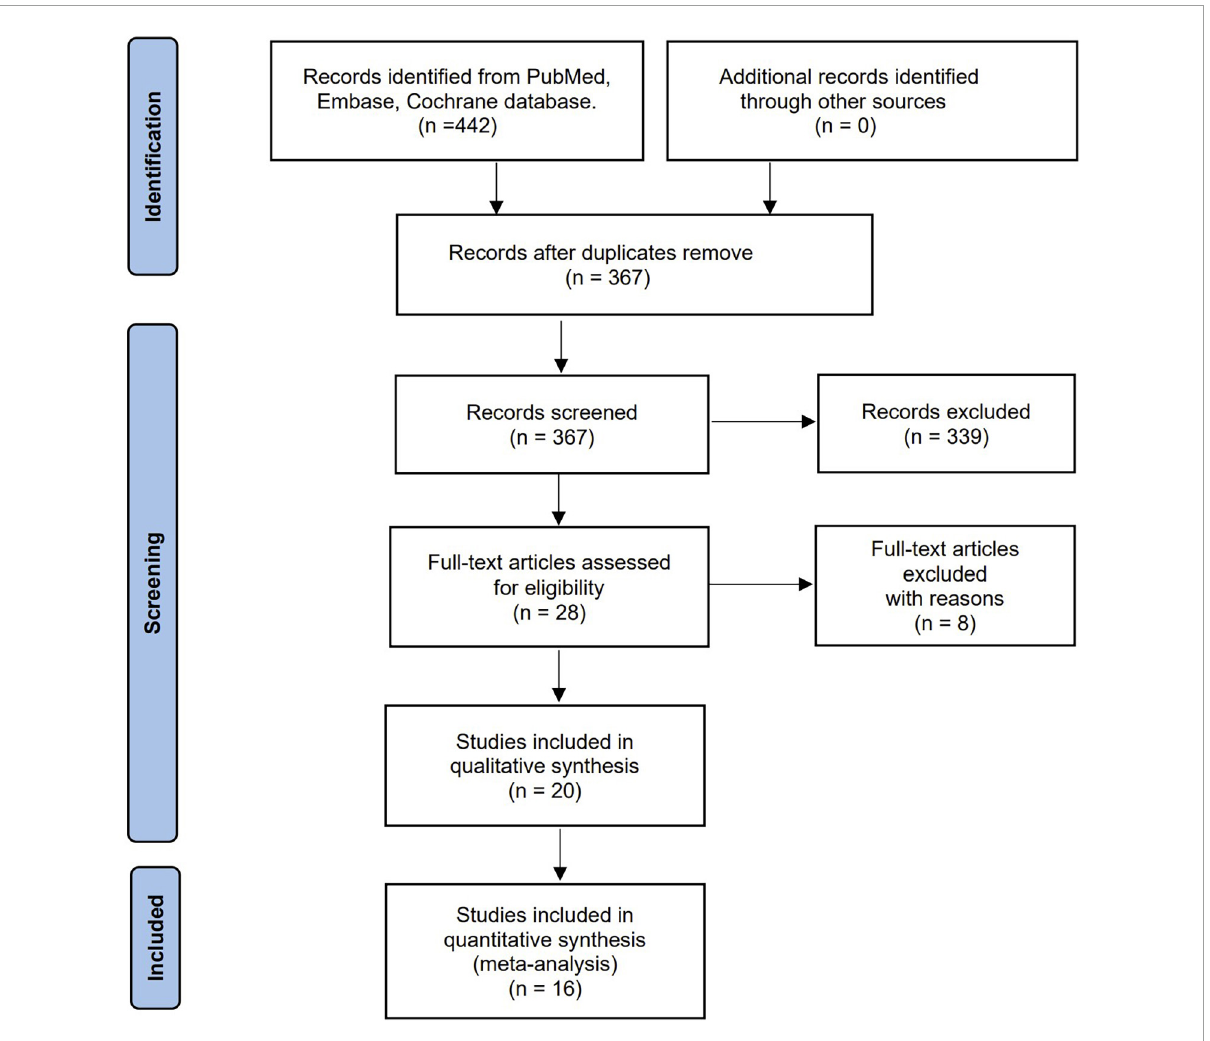
FIGURE1 Flow diagram for the identification of relevant